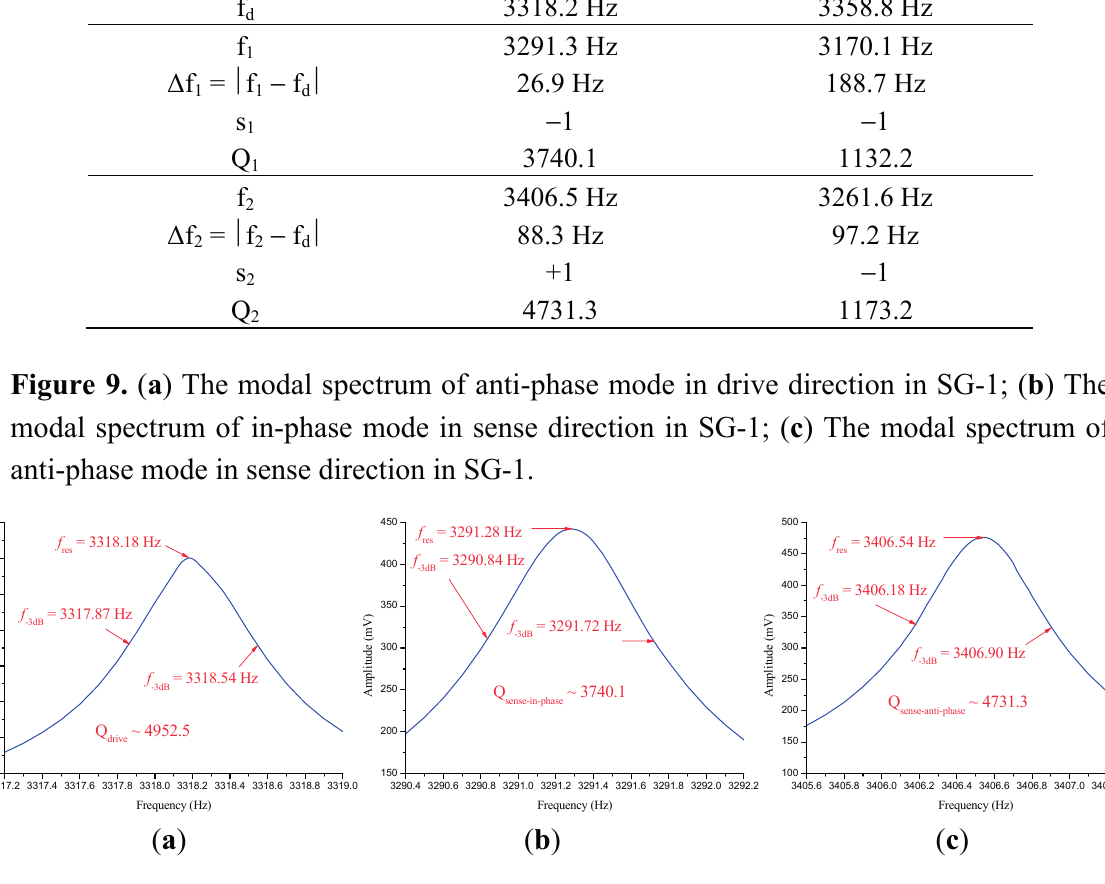
Figure 10. ( a ) The modal spectrum of anti-phase mode in drive direction in SG-2; ( b ) The modal spectrum of in-phase mode in sense direction in SG-2; ( c ) The modal spectrum of anti-phase mode in sense direction in